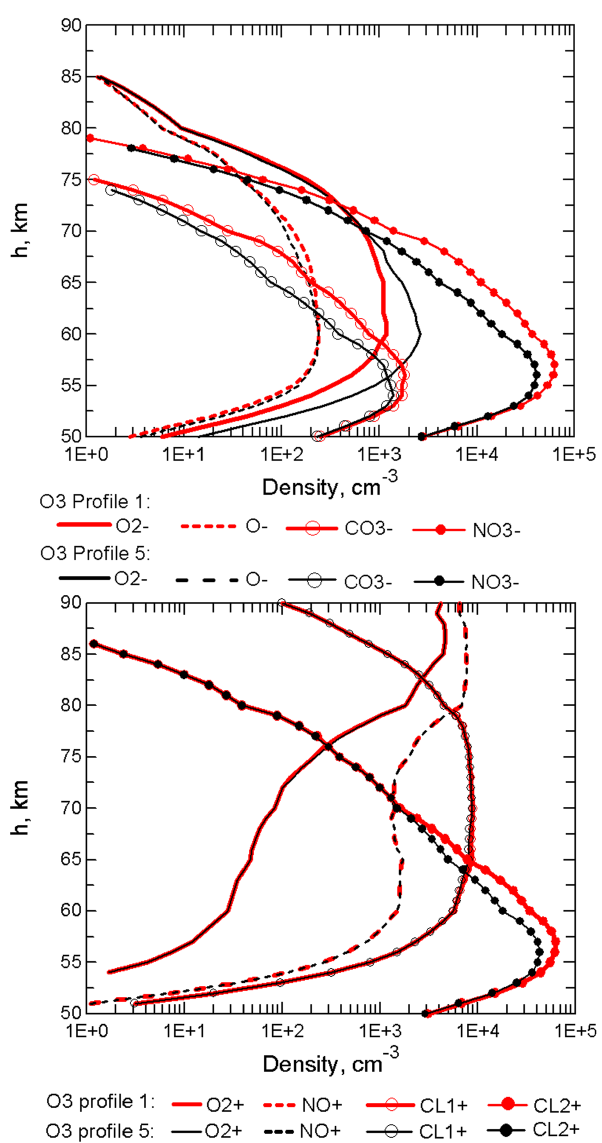
Fig. 7. Upper panel: The effect of different ozone concentrations (O 3 -profiles 1–6) on the theoretical value of electron density at dif- ferent altitudes for the SPE on 30 October 2003 at solar zenith angle Fig. 6. Upper panel: height distribution of the main negative ions 83.2 ◦ . Lower panel: The effect of different ozone concentrations O − , O − , CO − and NO − for different profiles of ozone concen- 2 3 3 (O 3 -profiles 1–6) on the value of theoretical electron density at dif- tration O 3 -profile 1 (red) and O 3 -profile 5 (black). Lower panel: ferent altitudes for the SPE on 29 October 2003 at solar zenith angle height distribution of the main positive molecular ions O + , NO + , 2 82.8 ◦ . Red curves are experimental (EISCAT) electron density pro- and clusters CL1 + , CL2 + , computed for the O 3 -profiles 1 (red) and O 3 -profile 5 (black).